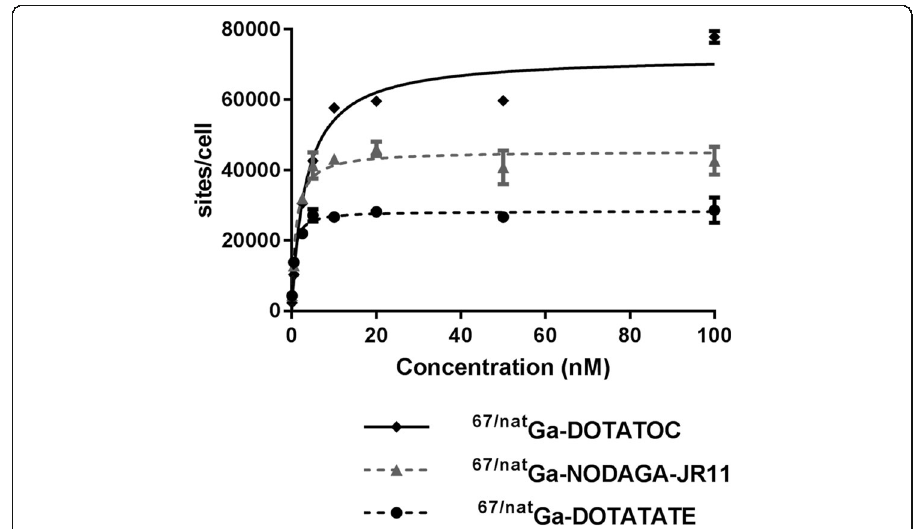
Fig. 2 Representative saturation binding curves for 67/nat Ga-NODAGA-JR11, 67/nat Ga-DOTATOC and 67/nat Ga-